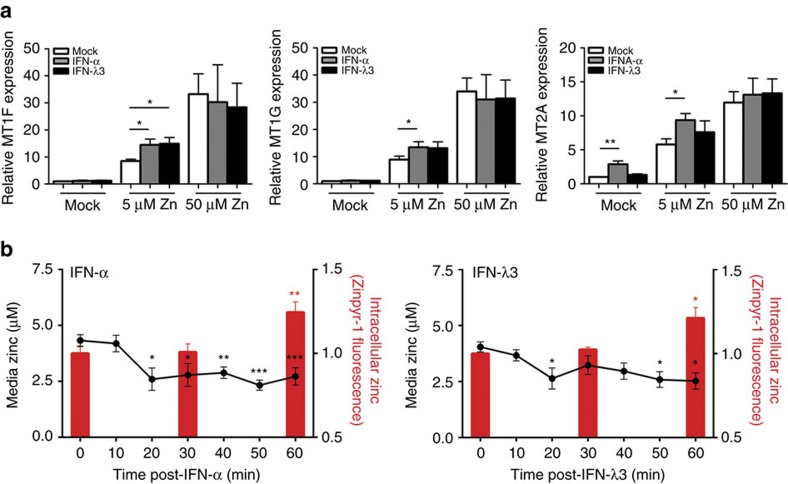
Interferon induces zinc influx and metallothionein expression in Huh-7 cells.(a) Huh-7 cells were with treated with either IFN-α or IFN-λ3 in media containing 1% FCS without additional zinc, 5 μM ZnSO4 or 50 μM ZnSO4. MT1F and MT1G were upregulated by interferons only in the presence of 5 μM ZnSO4, suggesting that their expression is mediated by zinc influx following interferon stimulation. Conversely, MT2A was upregulated by IFN-α even in the absence of zinc, suggesting differential regulation by interferon (Welch's t-test). (b) To confirm interferon-mediated zinc influx, cells were treated with IFN-α or IFN-λ3 and 5 μM ZnSO4 and intracellular/media zinc was measured using the zinc fluorophore Zinpyr-1. Both interferon treatments resulted in a zinc influx from the media into the cells, providing a mechanistic explanation for metallothionein upregulation following interferon treatment (one-way ANOVA). Data are representative of three independent experiments. *P<0.05, **P<0.01, ***P<0.001, (mean±s.e.).